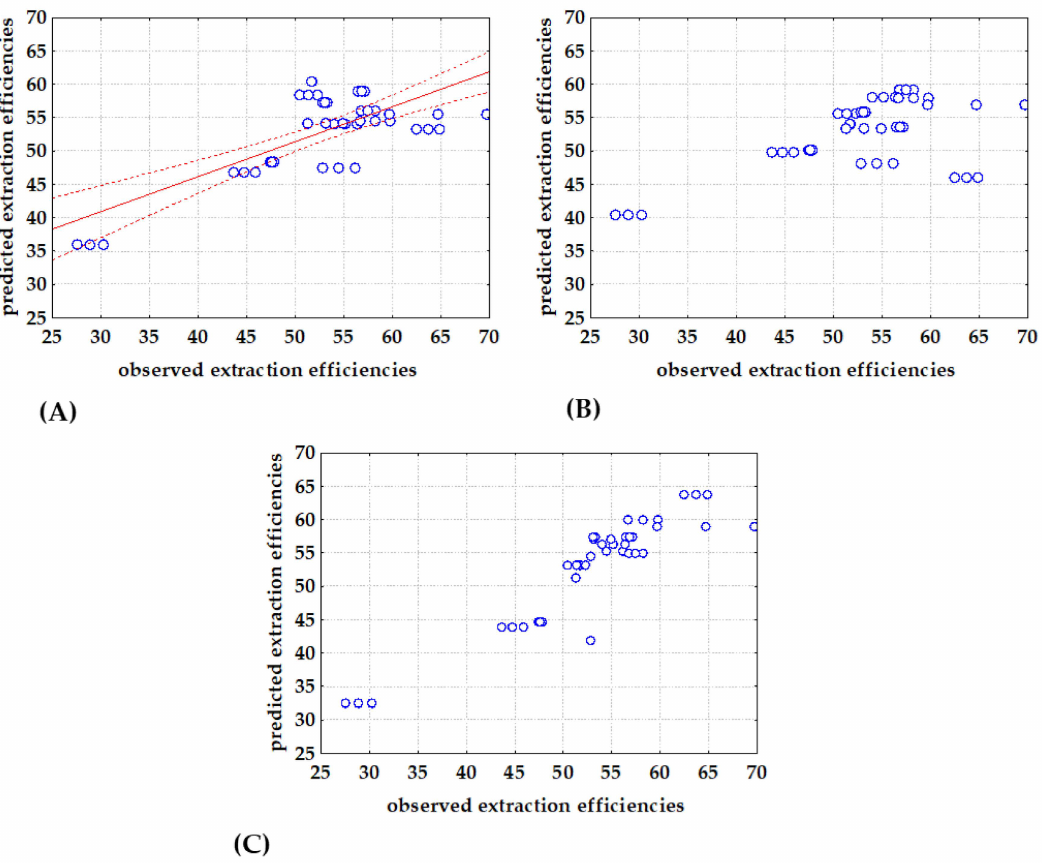
Figure 3. Comparison between observed and ( A ) MLR, ( B ) NLR and ( C ) PLR predicted extraction efficiencies based on DESs S i mix descriptors ( − regression line, ···· 95 % confidence